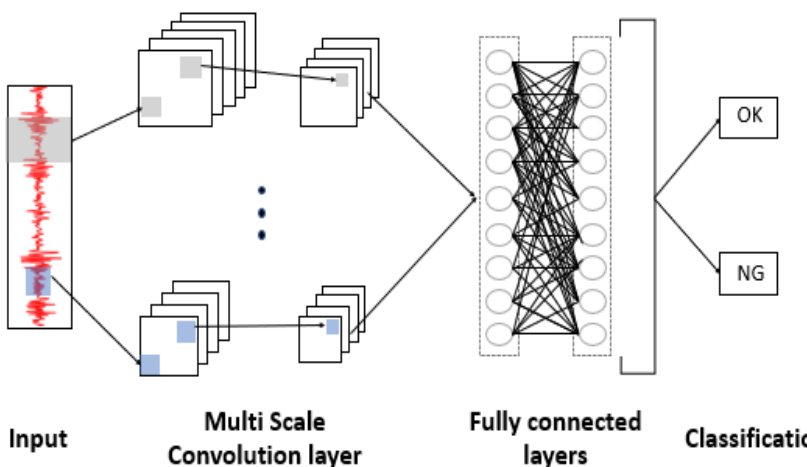
Figure 4. Structure of a multi-scale convolution neural network.